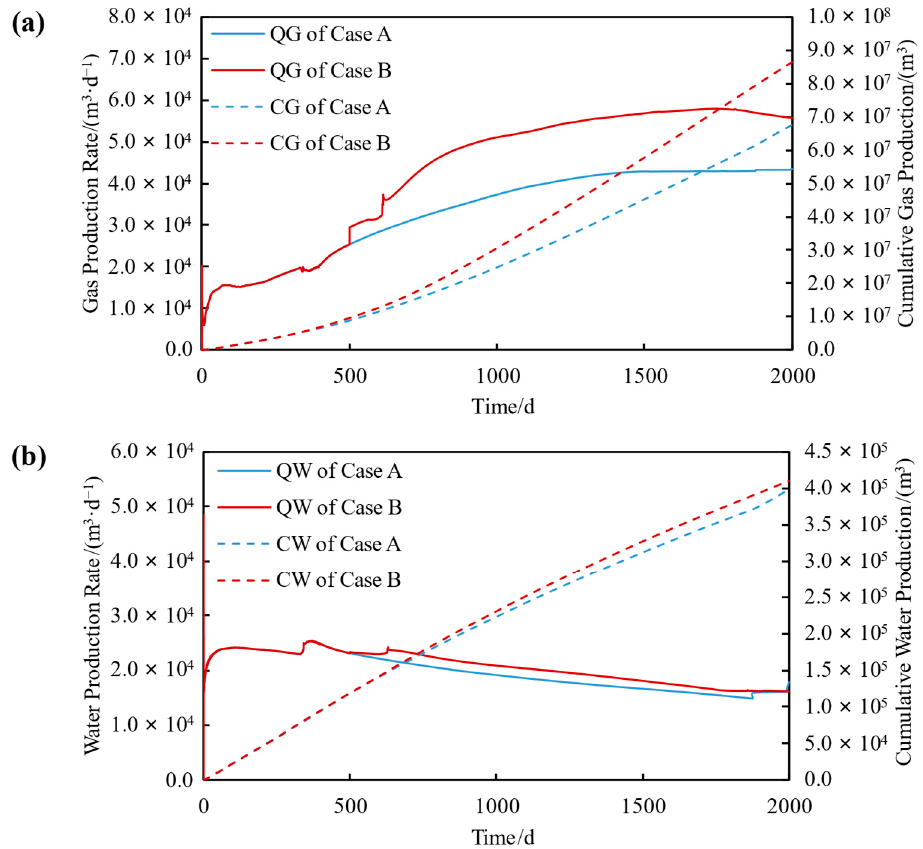
Figure 4. Comparison of gas ( a ) and water ( b ) production in Case A (depressurization only) and Case B (depressurization coupled with CO 2 exchange).